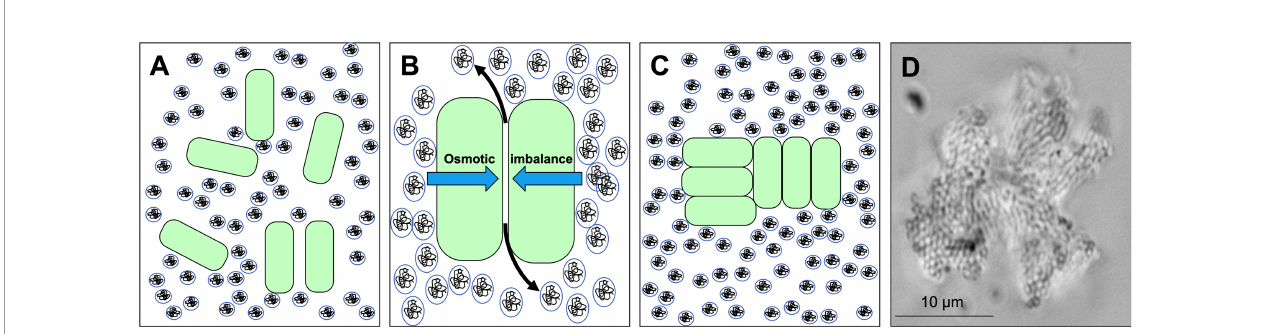
FIGURE 1 | Depletion aggregation aggregates bacterial cells in environments crowded with non-adsorbing polymers. (A) Bacterial cells (green) are suspended in an environment with high concentrations of non-adsorbing polymer (circles). (B) Polymers in between cells are restricted in their conformational freedom and spontaneously move out from in between cells (black arrows), increasing their entropy. The polymer concentration gradient across the cells produces an osmotic imbalance (blue arrows). (C) The osmotic imbalance (i.e., the depletion force) physically holds the cells together in aggregates. (D) Representative image of a P. aeruginosa PAO1 depletion aggregate with PEG 35 kDa as the